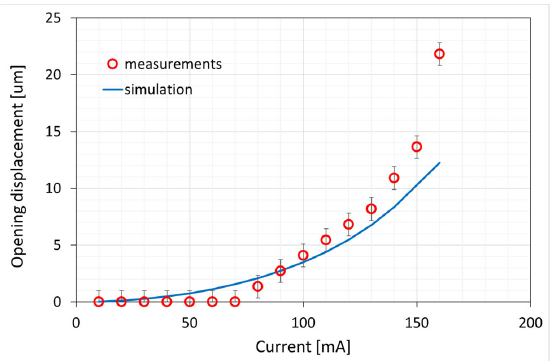
Figure 9. Measured and simulated displacement opening, g–g 0 , as function of input current. The error bars are +/ − 1.5 µm.